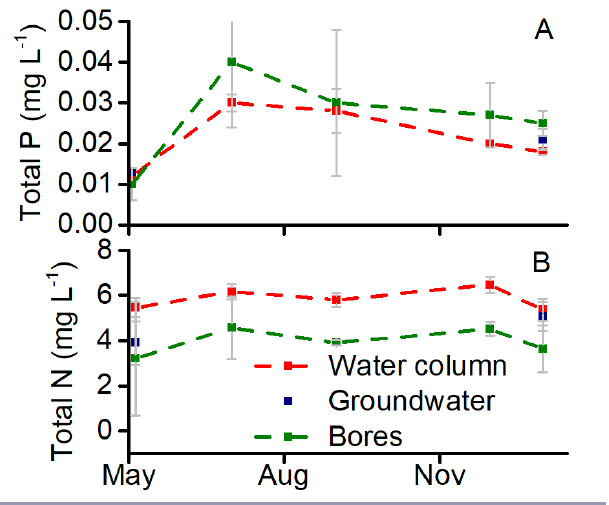
Fig. 2 . Nutrient concentrations: (A) Average total phosphorous and (B) total nitrogen concentration and standard error deviation (± SE) of 6 to 9 replicate samples in the water column of the ponds, individual groundwater samples from the ponds (measured in May 2014 and January 2015 only), and average concentration of water sampled at bores MAC045 and MAC094 in the unconfined aquifer (Fig. 1). Lines between points do not infer connection between the